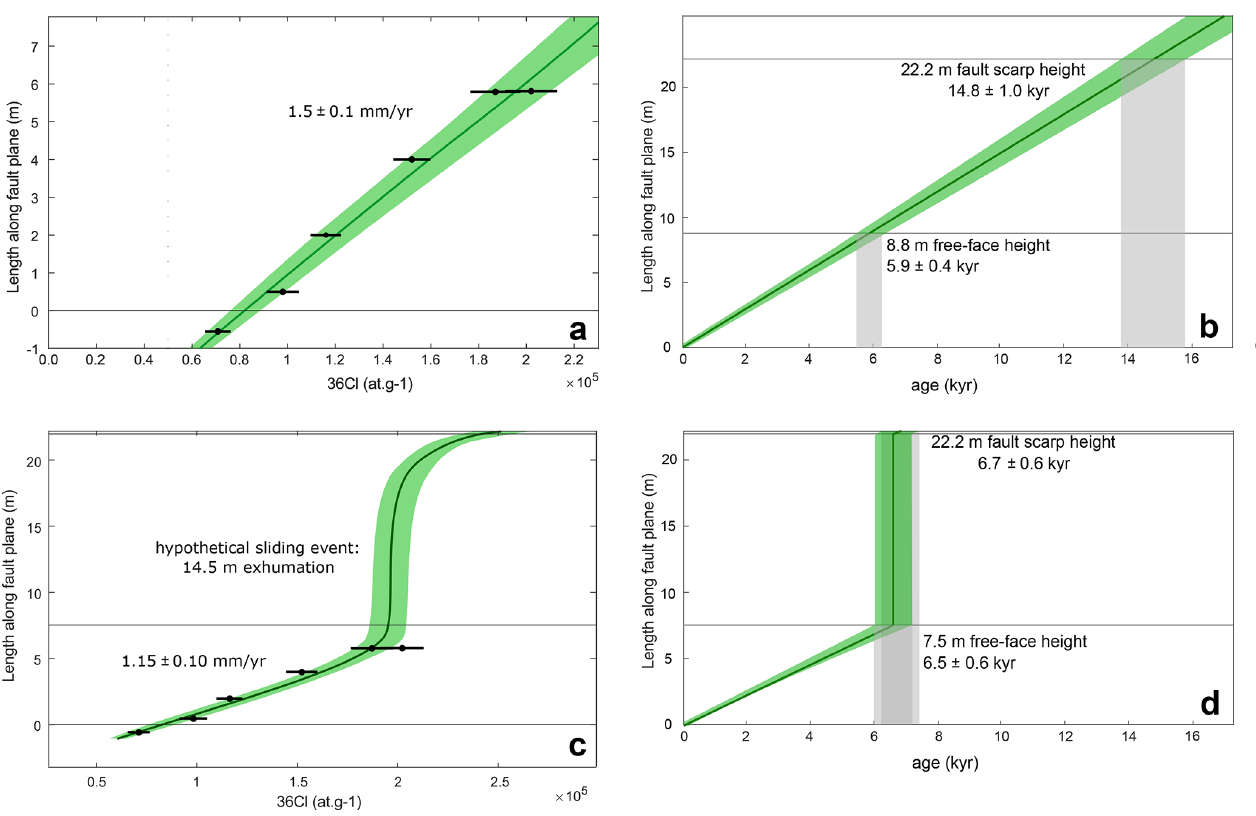
Figure 7. 36 Cl concentrations (1 σ deviations) as a function of the height up the scarp (distance measured on the free face). (a) Modeled 36 Cl concentrations for constant stick-slip rates (1.5 ± 0.1mmyr − 1 ) using the code of Schlagenhauf et al. (2010), with the highest likelihood. (b) The resulting correlation of age and scarp height of (a) . (c) Modeled 36 Cl concentration for the “most likely” landslide–rockfall scenario. (d) The resulting correlation of age and scarp height of (b)